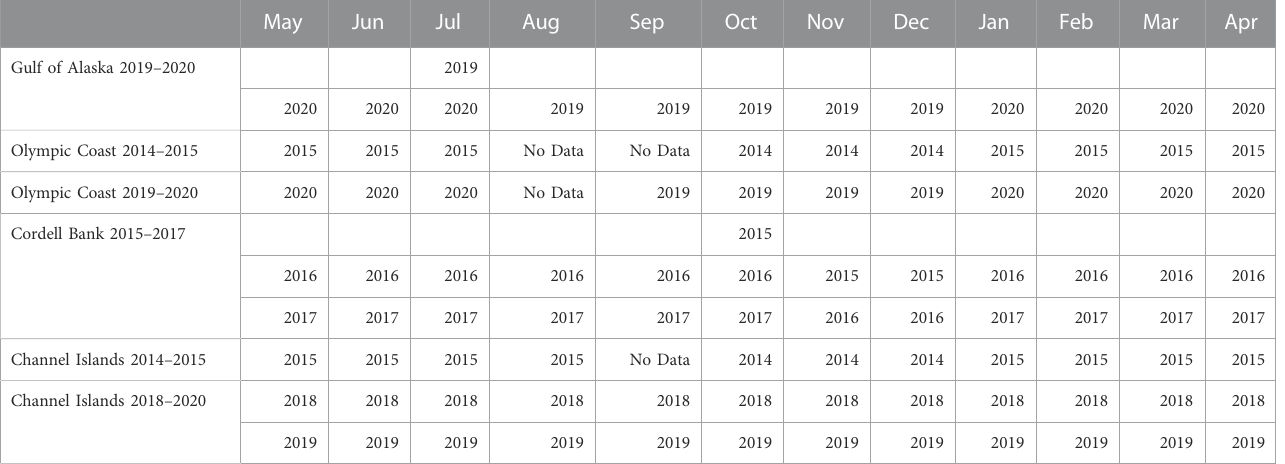
TABLE 2 Matrix of the year(s) in which each deployment had usable data for that